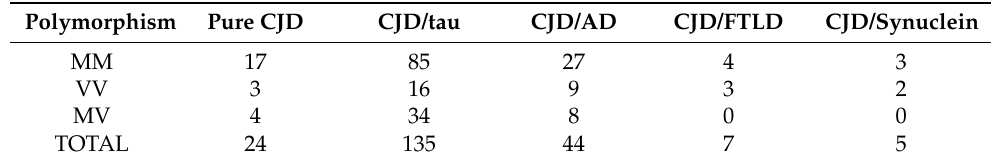
Table 2. Distribution of MV polymorphisms in pure and comorbid CJD